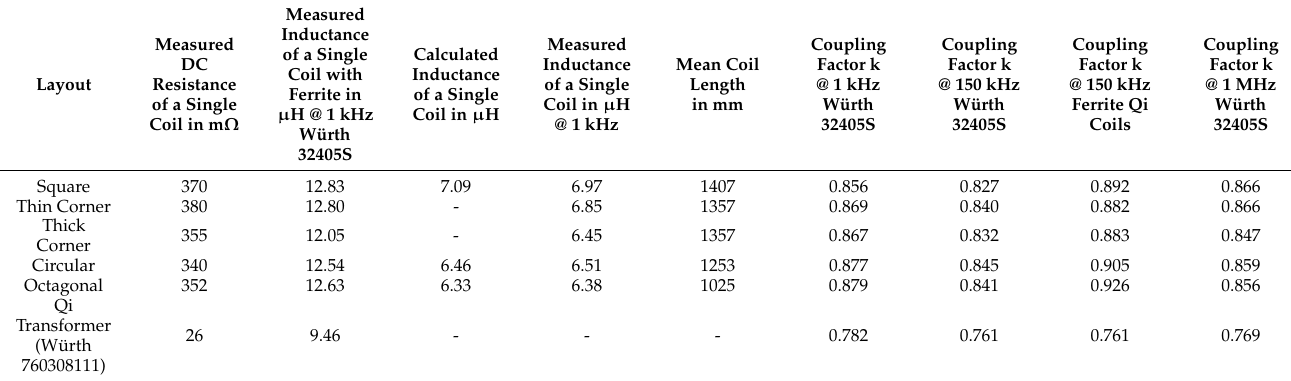
Table 1. Measured inductance of the different PCB